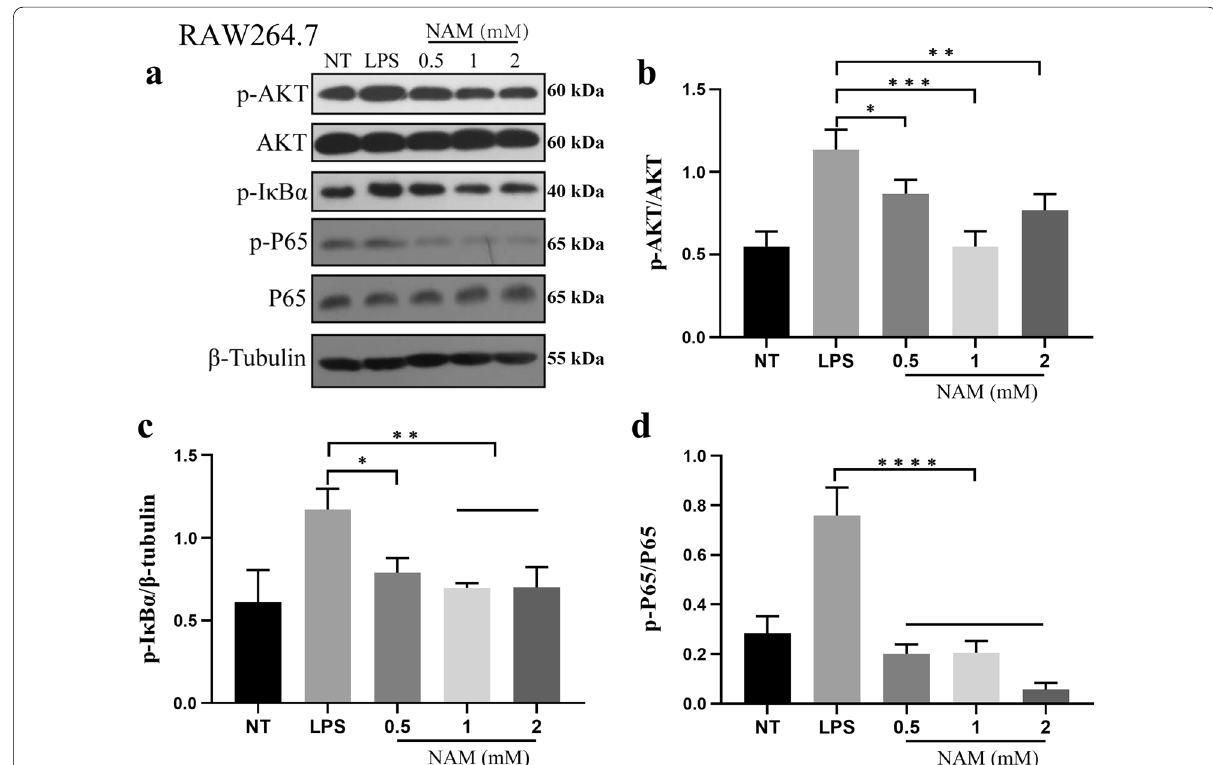
0.5 mM, LPS 1 mM + +